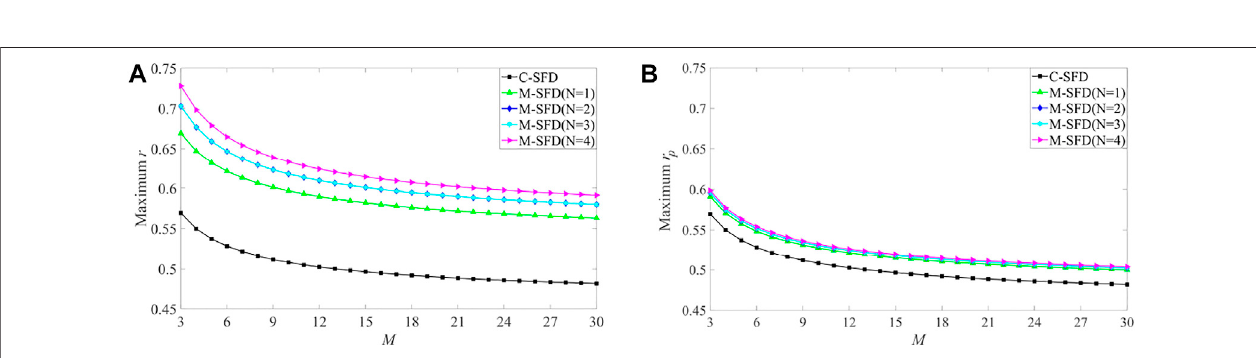
FIGURE 6 | Stability curves of the FD discrete (A) acoustic wave and (B) elastic wave equation given by C-SFD and M-SFD ( N =1, 2, 3, and 4). In (B) , the FD coef fi cients are calculated with the S-wave time – space domain dispersion relation for M-SFD ( N =1, 2, 3, and 4).